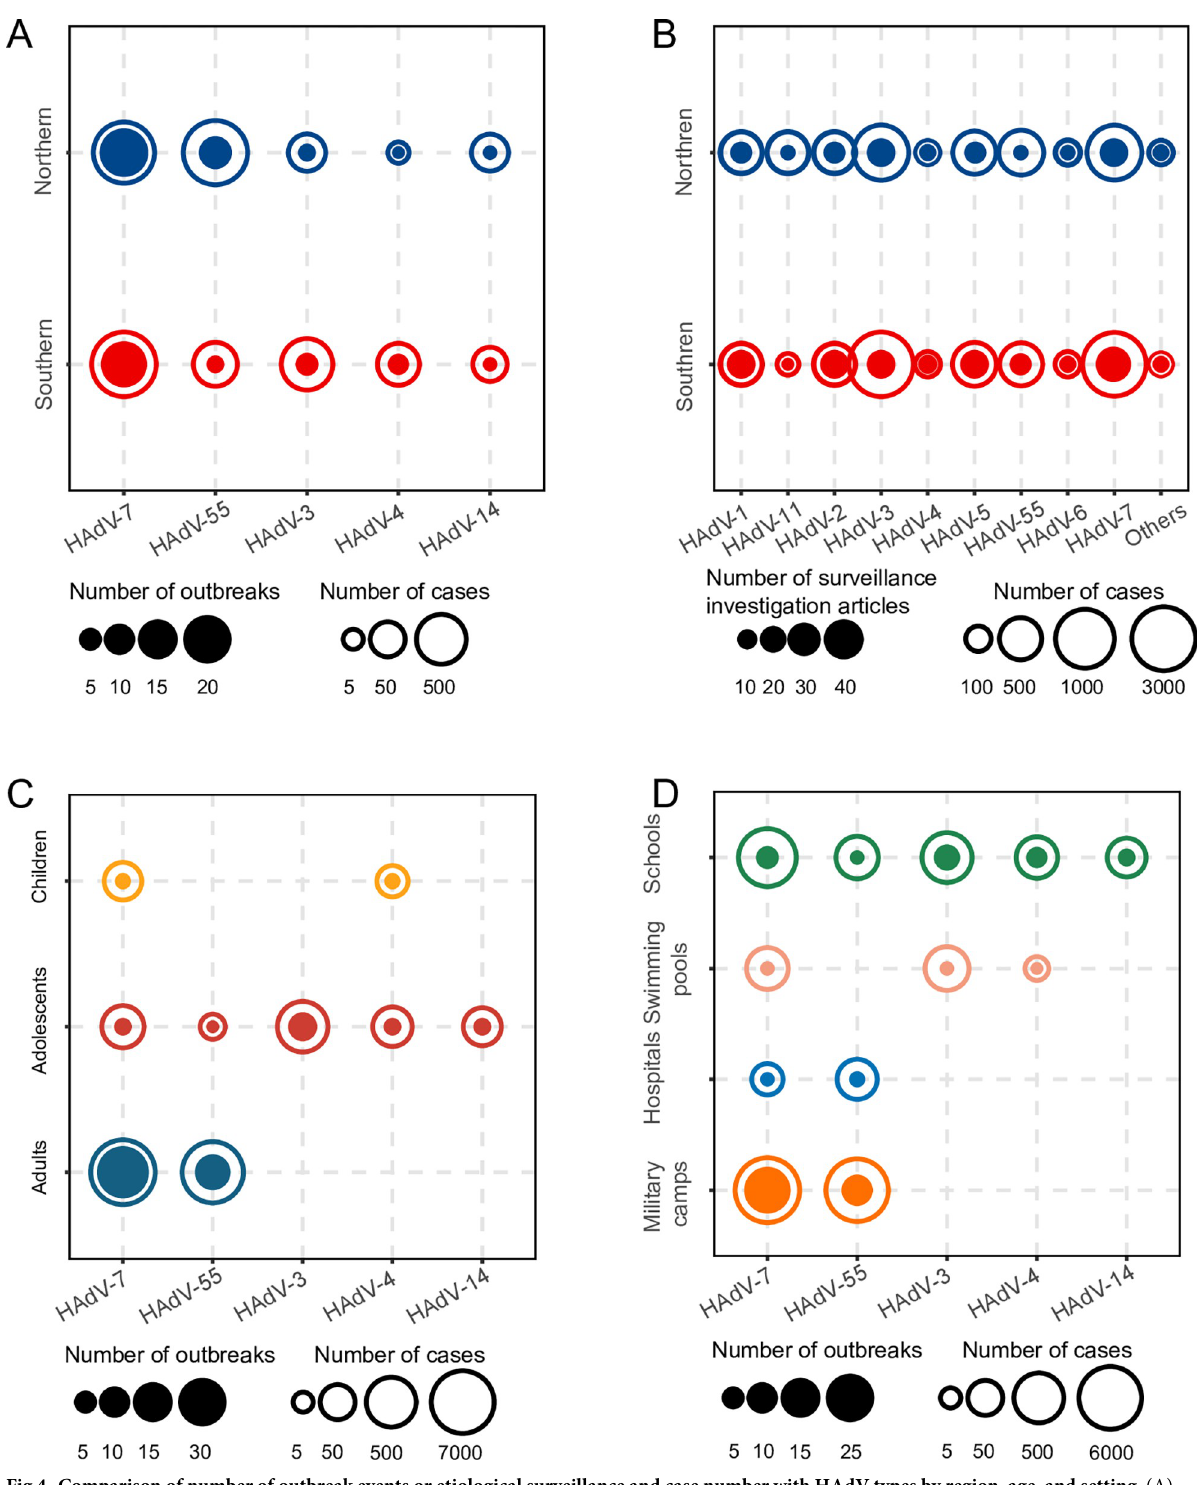
Fig 4. Comparison of number of outbreak events or etiological surveillance and case number with HAdV types by region, age, and setting. (A) outbreaks in different regions; (B) etiological surveillance in different regions; (C) outbreaks in different age groups; (D) outbreaks in different settings. Solid circles in panels A, C, and D indicate the number of outbreaks, and hollow circles indicate the number of cases. Solid circles in panel B indicate the number of etiological surveillances, and hollow circles indicate the number of cases.